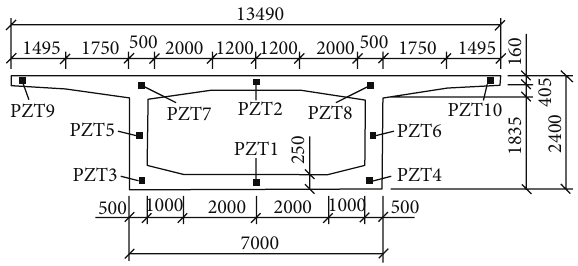
Figure 13: Arrangement of PZT sensors in section D.